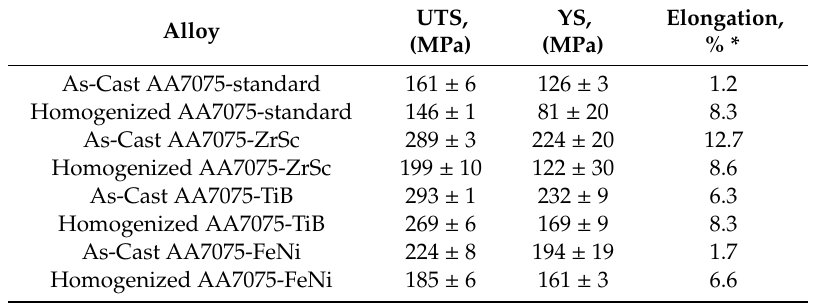
Table 2. Ultimate tensile strength (UTS) results of the investigated alloys in as-Cast and homogenized